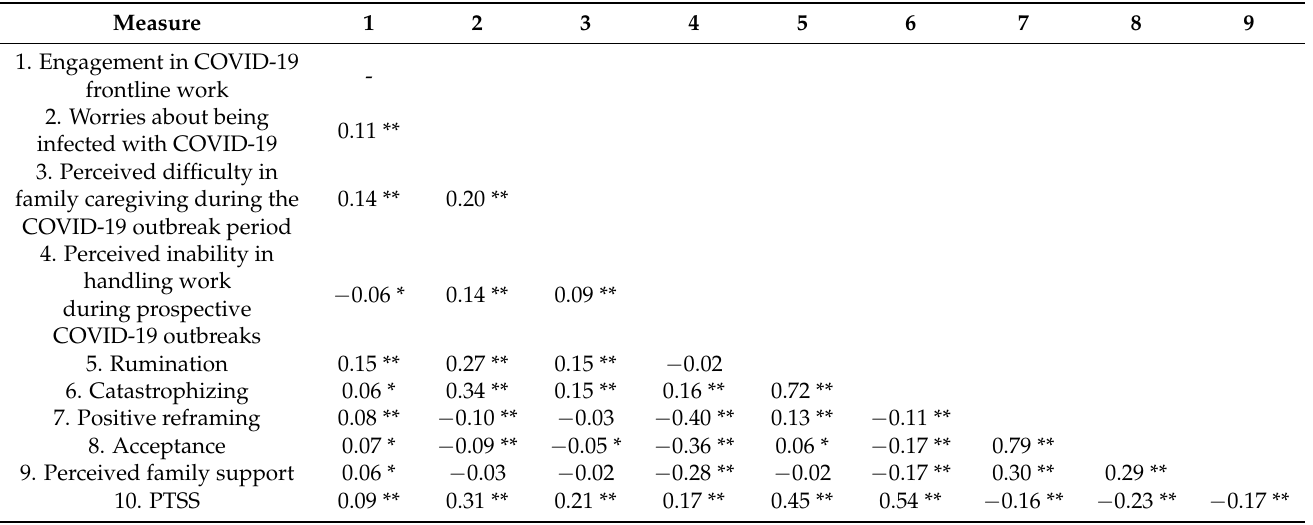
Table 3. Correlations between the studied